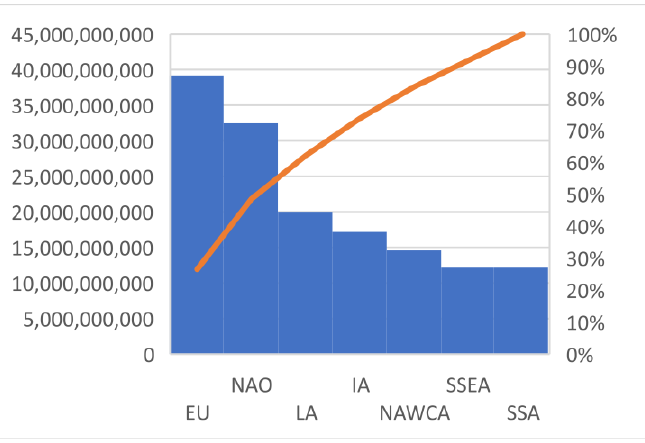
Figure 2. Worldwide distribution of MFW (to of food) associated with overweight and obesity.